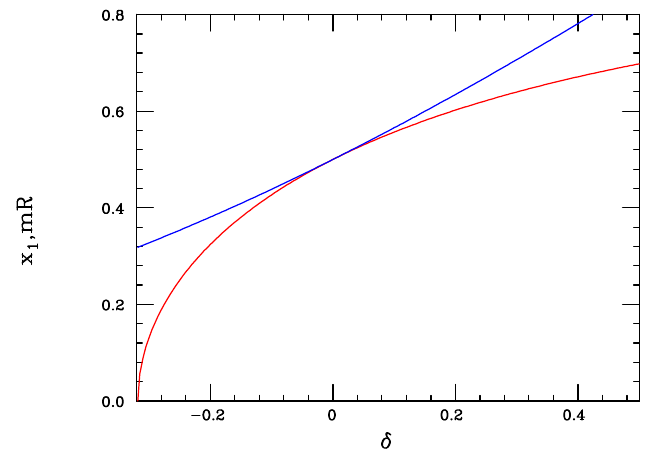
Figure 3 . The value of the smallest real root (red) and corresponding dimensionless DM mass as functions of (cid:14)